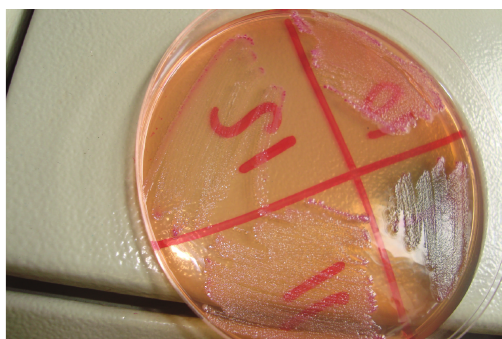
Figure 1: Sorbitol-nonfermented colonies of E. coli O157:H7 on CT- SMAC media.